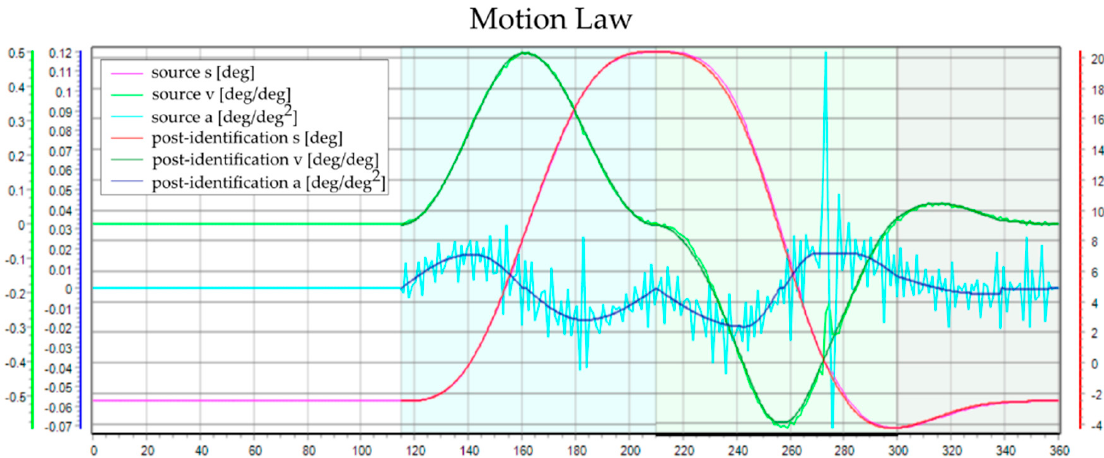
Figure 15. Comparison between the experimental law of motion (light blue) and modified trapezoidal laws for each phase (with equal coefficients values) after identification based on acceleration by adopting the EN.